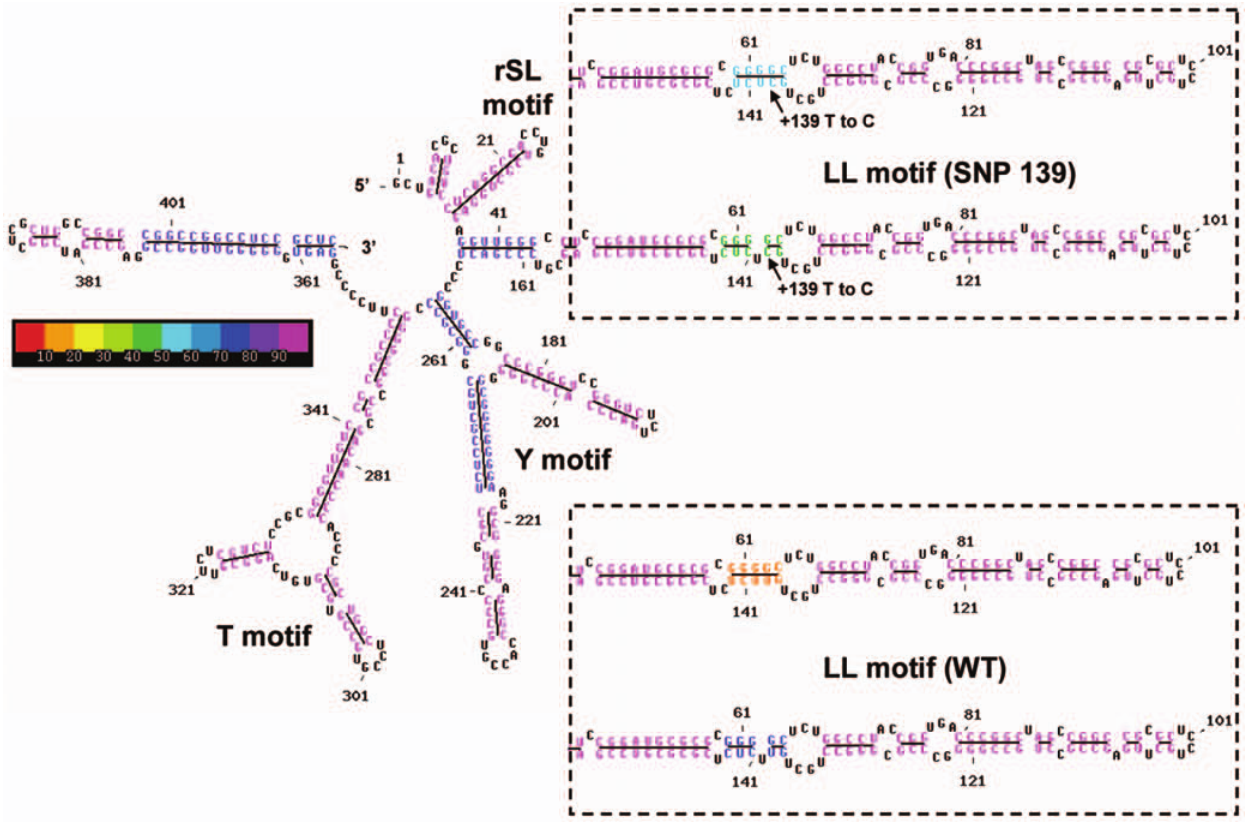
Figure 6. Dominant secondary structures predicted by MPGAfold for the + 1 to + 414 5 9 -leader sequence of 45S rRNA. The stems are color-coded (scale shown) based on their frequency of occurrence in the final structure among 20 runs at the population level of 128 K. Unpaired bases are black. The basic structure at left was highly conserved and was as shown in all but 4/40 of the final predictions. The dashed boxes at right showed alternative conformations of the LL motif surrounding the + 139 site, which differ for the 5 nucleotides at 60–64 and 138–142. For the wild- type, + 139 U (bottom dashed box), the conformation of these nucleotides involved predominately a 3-nucleotide stem and a looped-out U at + 140 (dark blue in the diagram). This LL motif variant was found in 80% (16/20) of the final structures, with E= 2 246.1 kcal/mol in all but one of these. The LL motif structures with the 5 nucleotides in orange, all as part of the stem, were in the minority, 20% (4/20) of all solutions (see Table 3). The full structure illustrated was identical for all but one of these, with E= 2 245.9 kcal/mol. By contrast, for the SNP + 139 C (top dashed box) the two conformations were presented in similar proportions, 45% as the 3-nucleotide stem (green), E= 2 248.8 kcal/mol, and 55% as the 5-nucleotide stem (light blue), E= 2 248.4 kcal/mol.